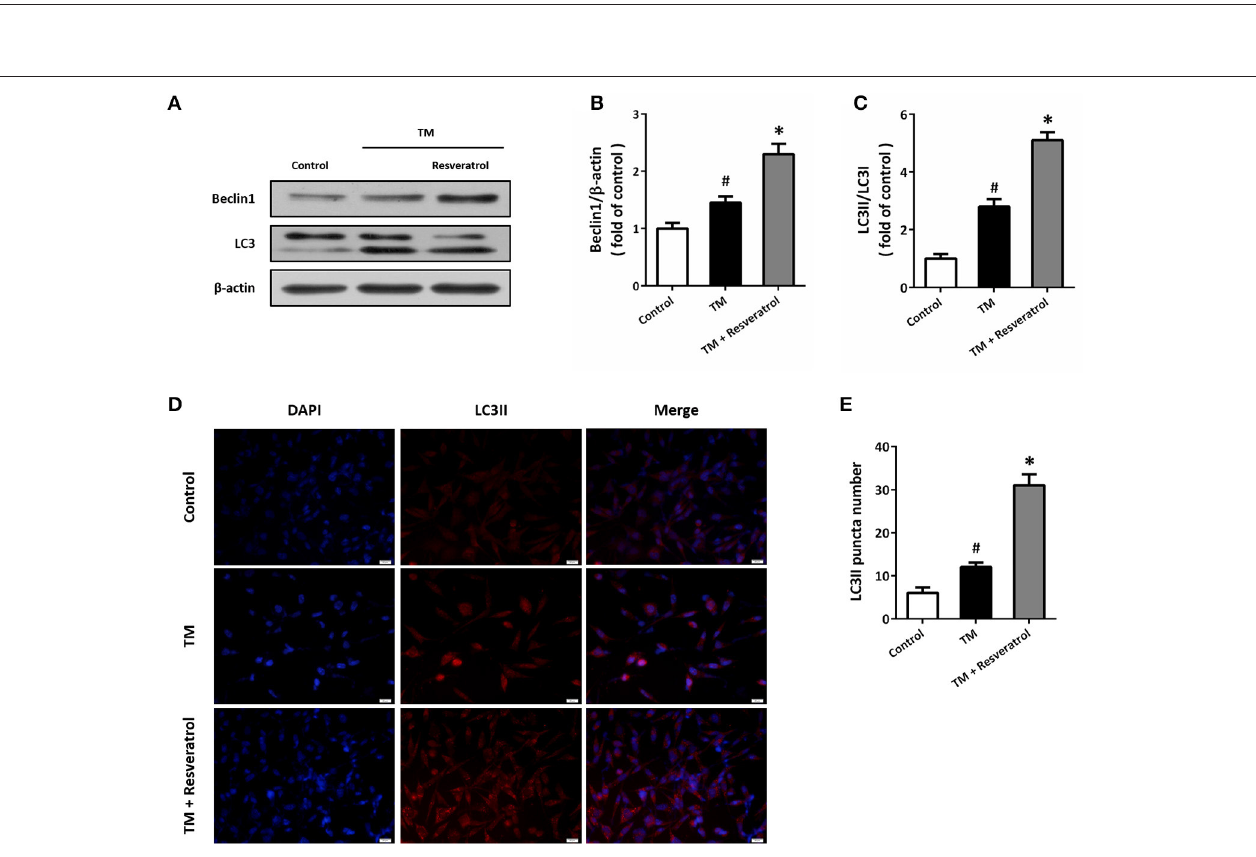
FIGURE 3 | Resveratrol promotes autophagy in HT22 cells after TM exposure. HT22 cells were treated with 100ng/ml TM with or without 50 µ M resveratrol for 24h. The expression of Beclin1 and LC3 was detected by western blot (A–C) . Immunofluorescence staining of LC3II was performed to assess autophagy in HT22 cells (D) , and the number of LC3-positve puncta was counted (E) . Data are shown as mean ± SEM. # p < 0.05 vs. Control. * p < 0.05 vs. TM. Scale bar = 20 µ m.